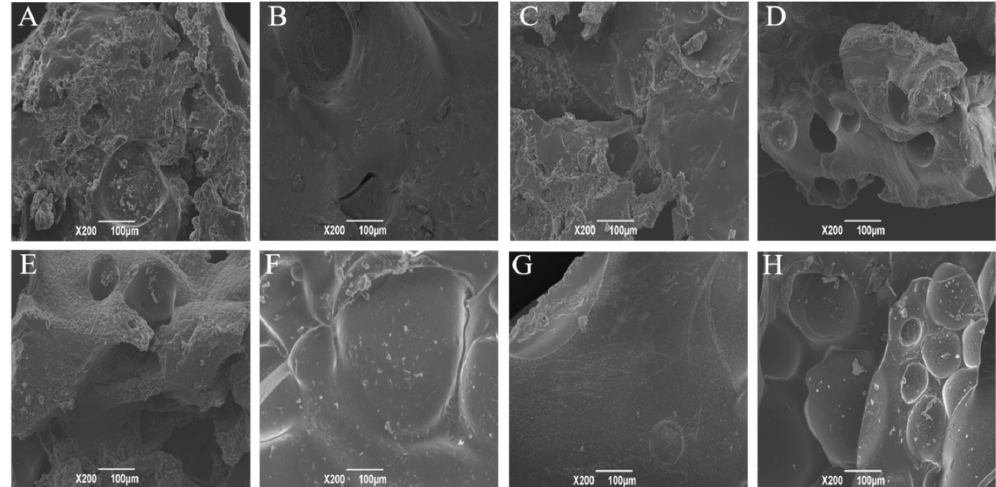
Figure 7. Effect of high-intensity ultrasound treatment (20 kHz at 400 W for 0, 5, 20, 40 min) on the SEM micrographs of lyophilized CSPI and DGH. ( A ) CSPI-0 min, ( B ) CSPI-5 min, ( C ) CSPI-20 min, ( D ) CSPI-40 min; ( E ) DGH-0 min, ( F ) DGH-5 min, ( G ) DGH-20 min, ( H ) DGH-40 min.